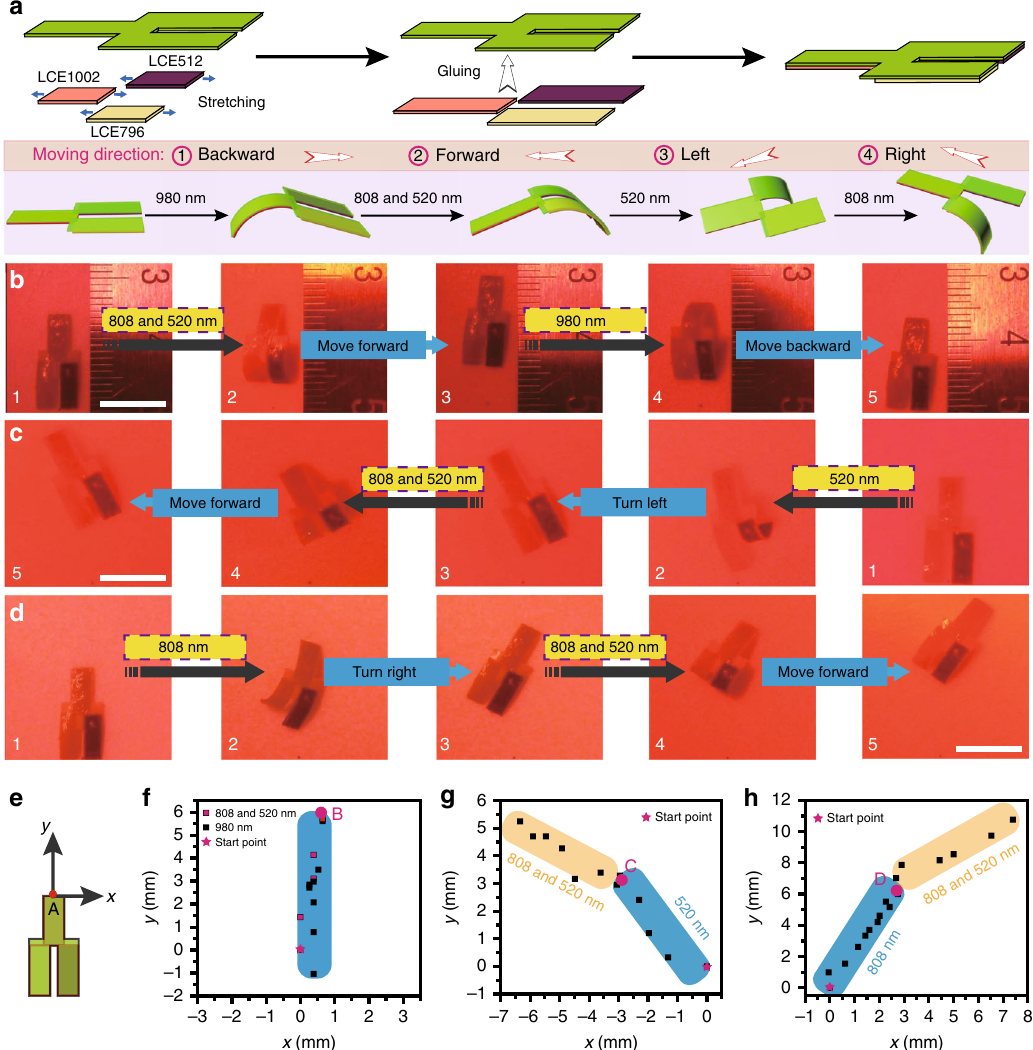
Fig. 5 Photo-modulated multi-directional bilayered LCE walker. a Schematic illustration of the fabrication protocol and the moving mechanism of a multi- directional bilayered LCE walker. Photographs showing the multi-directional walker ( b ) moving either forward or backward upon on-off irradiation of 808/ 520 nm or 980 nm light, c moving left and then forward upon on-off irradiation of 520 nm and then 808/520nm light, d moving right and then forward upon on-off irradiation of 808 nm and then 808/520nm light. e The de fi nition of the starting position coordinate of the LCE walker in x – y plane. The real- time position coordinate of the midpoint A of the LCE walker recorded in f moving forward and backward manner, g moving left and then forward manner, h moving right and then forward manner. Scale bar = 1.0 cm. Source data are provided as a Source Data fi le